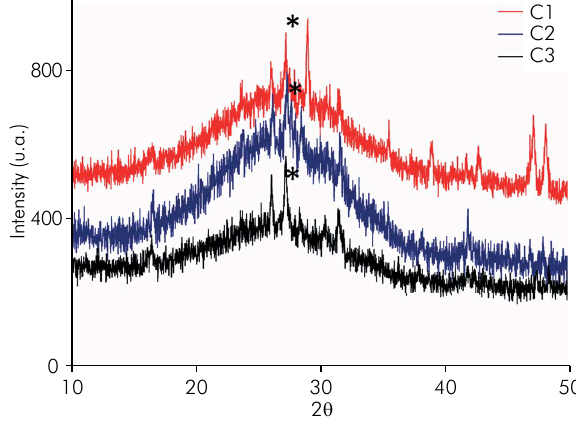
Figure 1. XRD graphs of C1, C2, and C3 groups. Asterisks represent the predominant peak of